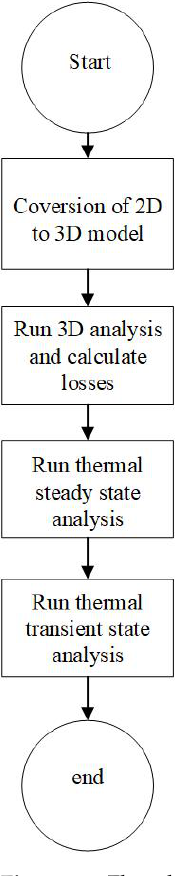
Figure 18. Flowchart of thermal analysis.